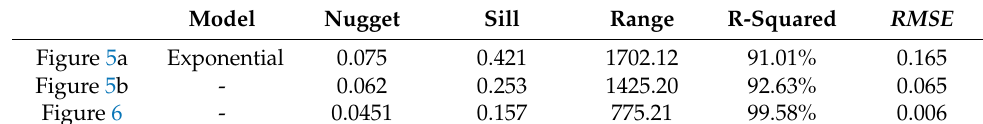
Figure 5. Experimental variograms at initial steps of R-Squared = ( a ) 91.0% ( b ) 92.6%. Table 1. Experimental variogram outputs (units in meters and percentages).